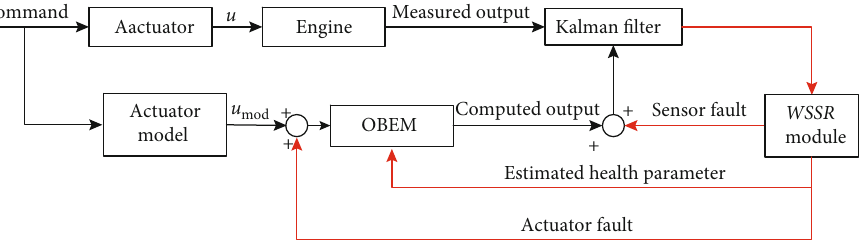
Figure 5: General structure of an improved HFE.